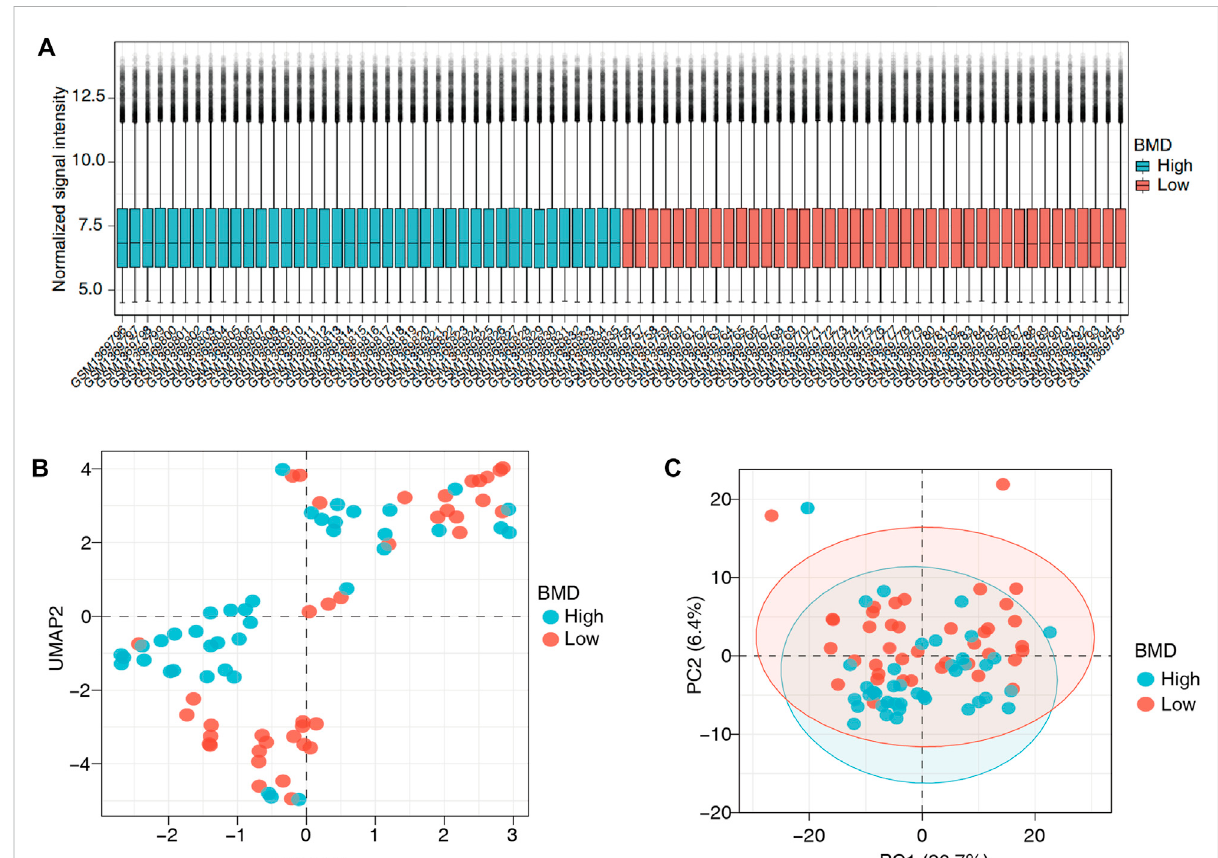
Standardization of gene expression. (A) Box plots of the gene expression data after normalization. (B) The uniform manifold approximation and projection (UMAP) plot and (C) principal component analysis (PCA) plot show the differences in gene expression between the two groups. The blue points represent the high bone mineral density (BMD) data, and the red points represent the low BMD